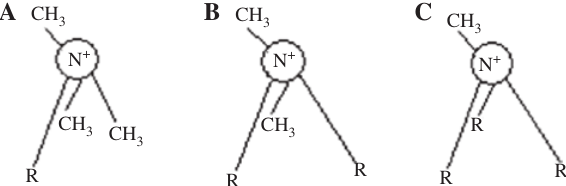
Figure 2 Configuration of the nitrogen atom in LACQAS.